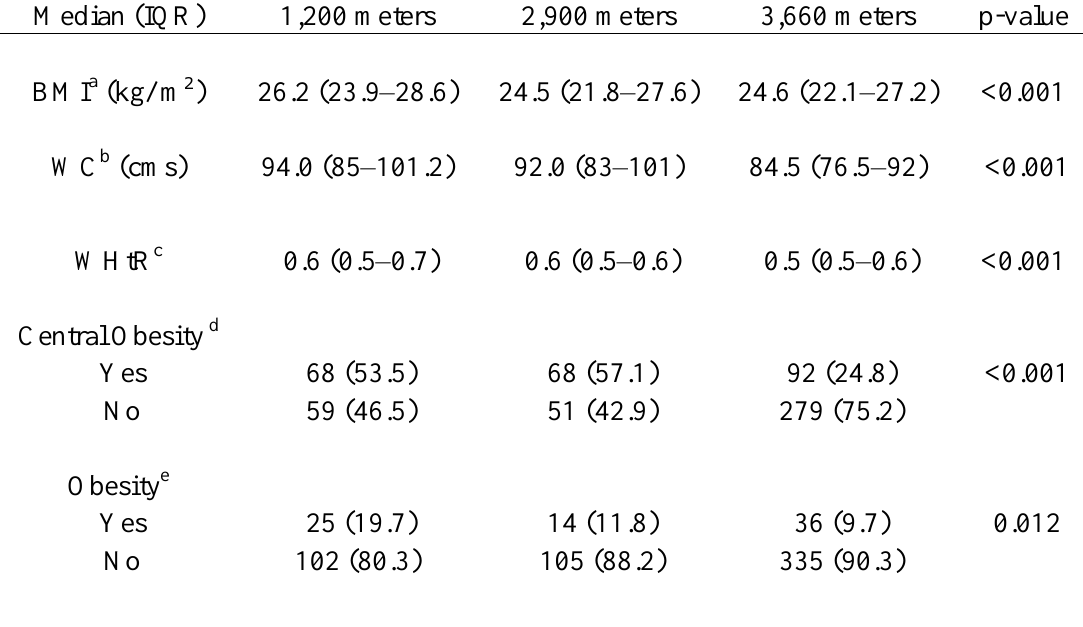
Table 2. Obesity parameters by altitude of